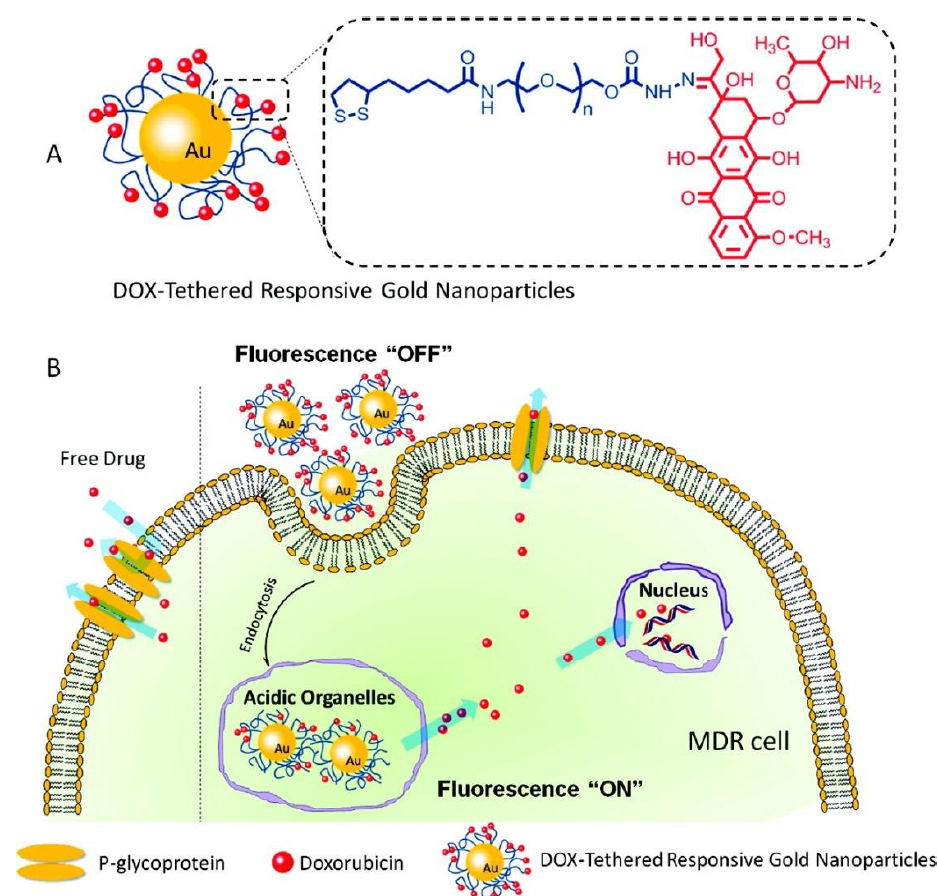
Figure 4. ( A ) Schematic illustration of doxorubicin (DOX)-tethered responsive gold nanoparticles and ( B ) their cooperation between enhanced doxorubicin cellular entry and a responsive intracellular release of doxorubicin into the cells to overcome drug resistance [104].